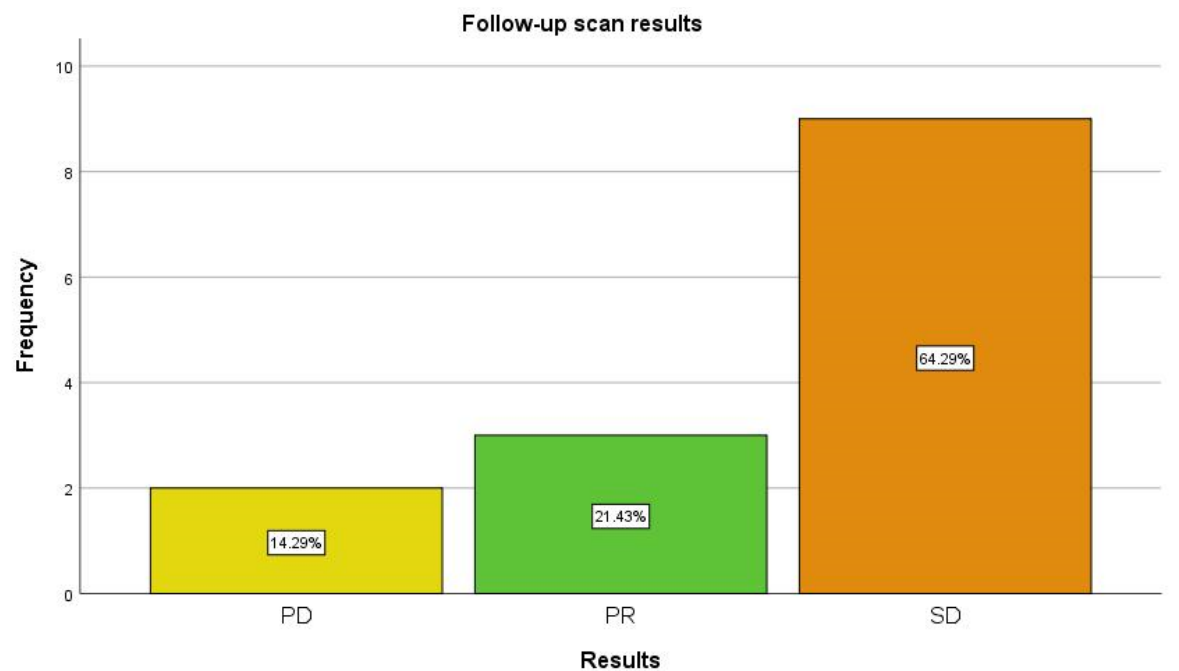
Figure 2. Patient distribution after follow-up examinations. Abbreviations: PD—progressive disease; PR—partial response; SD—stable disease.